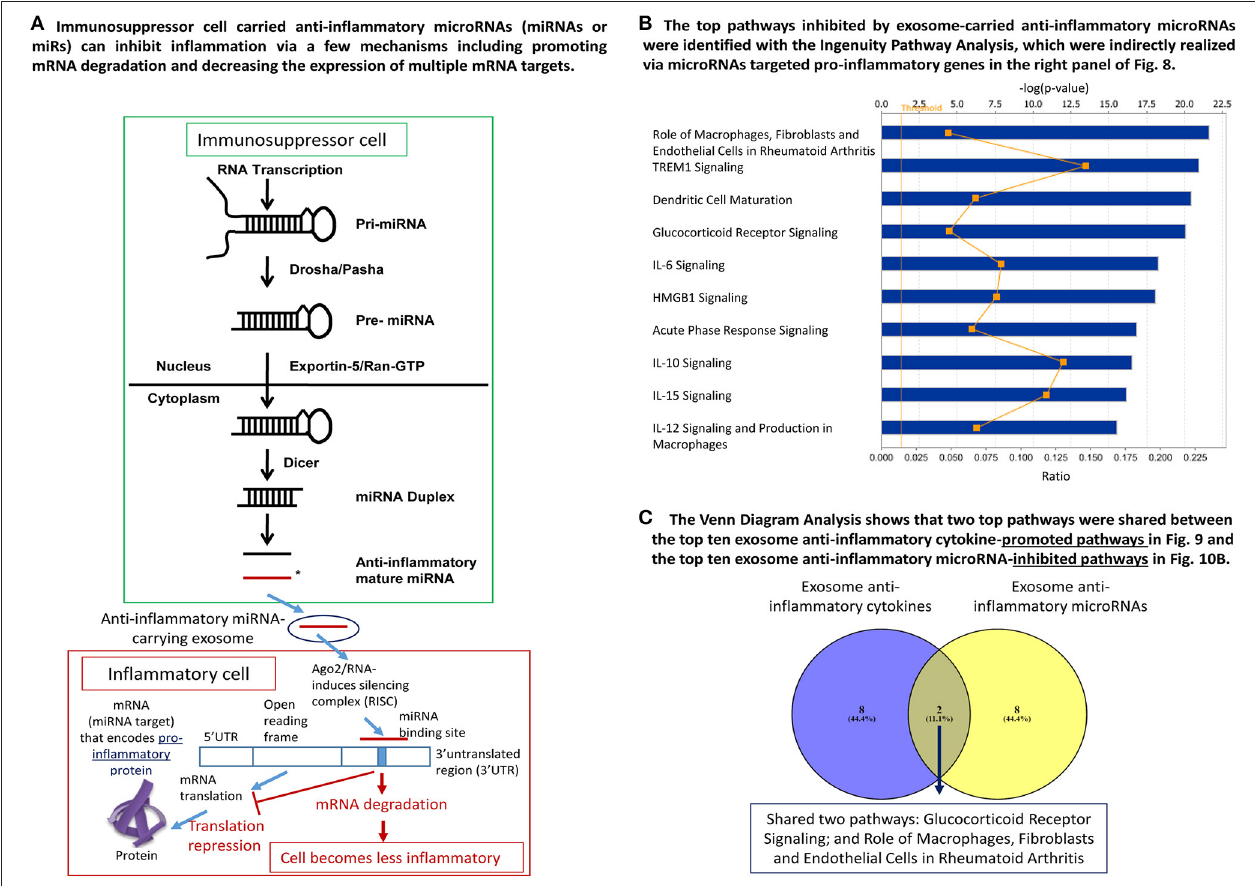
FIGURE 10 | MiRNA in immune cell derived exosomes exert anti-inflammatory effects. (A) Graphical representation of how miRNA inhibit inflammation by promoting mRNA degradation and decreasing the expression of multiple mRNA targets. (B) The major pathways that are inhibited by the miRNA that are transported in exosomes derived from immune cells. (C) Venn analysis revealed that only 2 signaling pathways are shared by the anti-inflammatory cytokines and miRNA found in the exosomes generated by immune